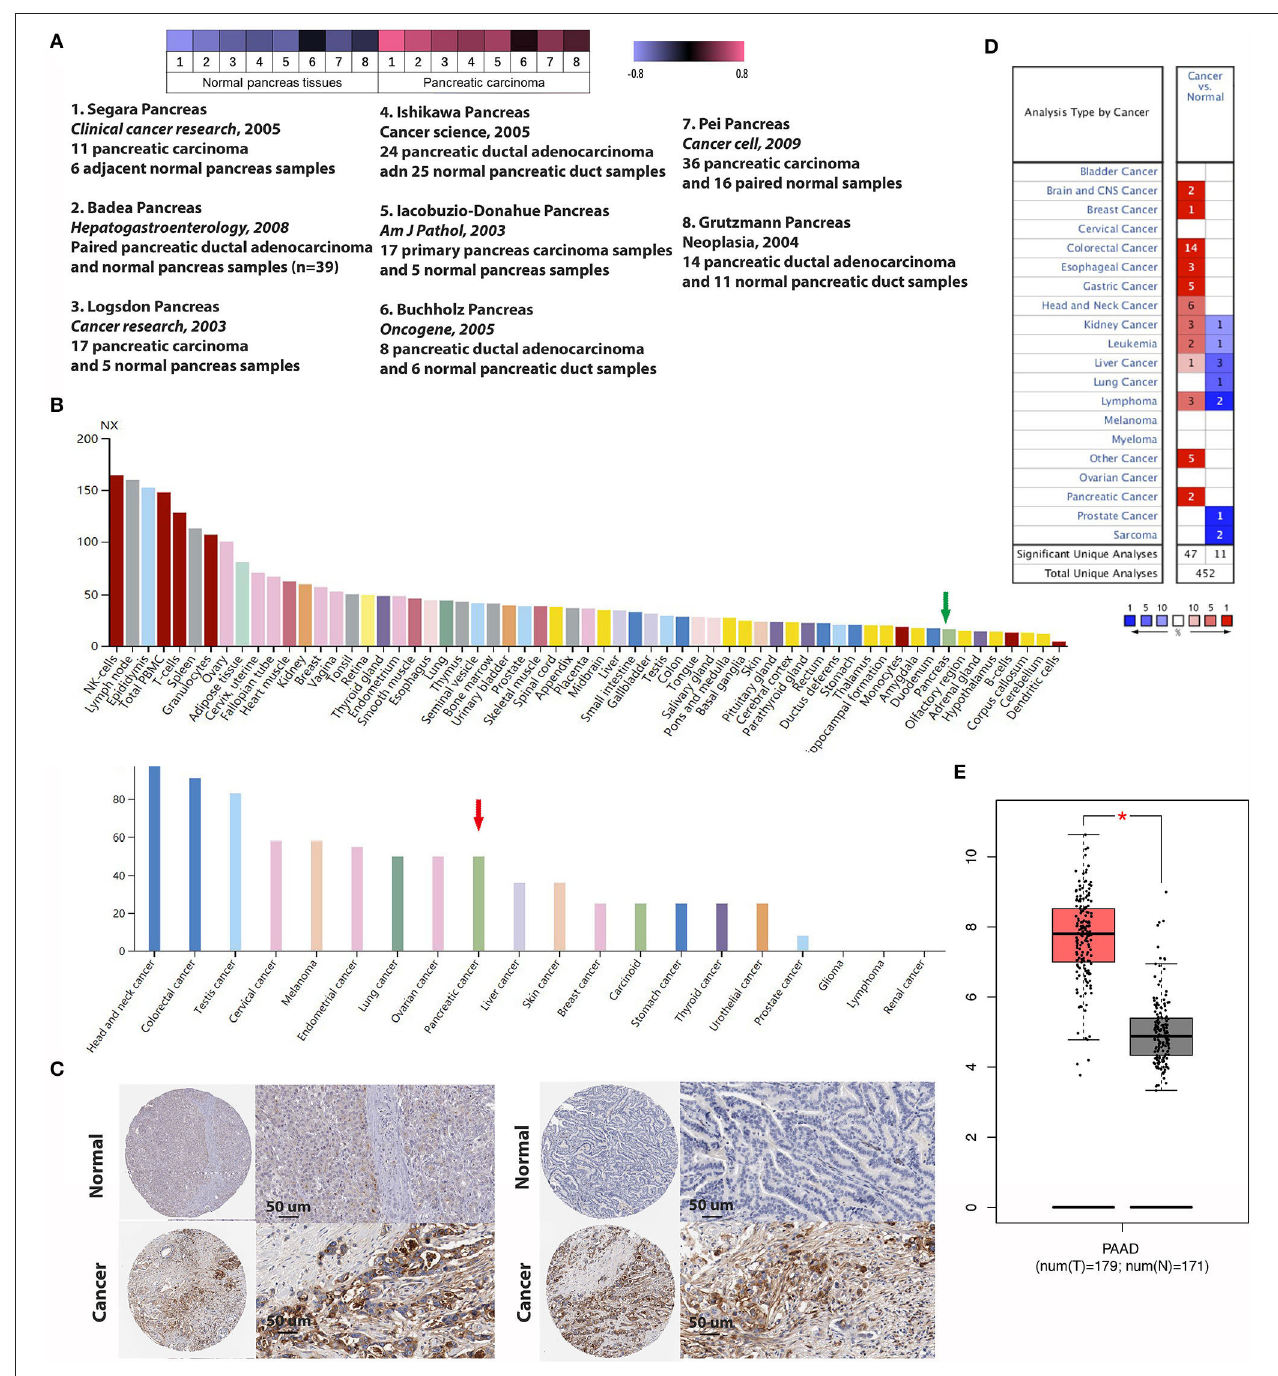
FIGURE 4 | The expression of IFN-induced transmembrane protein 1 (IFITM1) between pancreatic cancer and normal pancreas samples. (A) Heat map of IFITM1 associated with pancreatic cancer among eight studies. (B,C) An overview of IFITM1 levels in pancreatic tumors and normal pancreatic tissues and immunohistochemical analysis of IFITM1 expression in pancreatic cancer and normal pancreatic tissues. Data were derived from the Human Protein Atlas database. (B) The green and the red arrows represent normal pancreatic tissue and pancreatic cancer, respectively. (C) Top: Protein levels of IFITM1 in normal tissue (staining: negative; intensity: negative; quantity: none); bottom: Protein levels of IFITM1 in pancreatic cancer tissue (staining: high; intensity: strong; quantity: > 75%). (D) mRNA levels of IFITM1 in 20 types of cancers vs. normal tissues. The figure represented the number of data sets involving statistically significant upregulated (dark) as well as downregulated (light) expression of IFITM1. (E) The box plot shows the expression profile of the IFITM1 based on GEPIA. The red node represents pancreatic cancer, and the gray node represents normal samples. * p < 0.05.